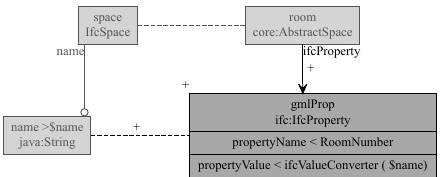
Figure 6. A rule similar to the one in Figure 5 working around an implementation issue.